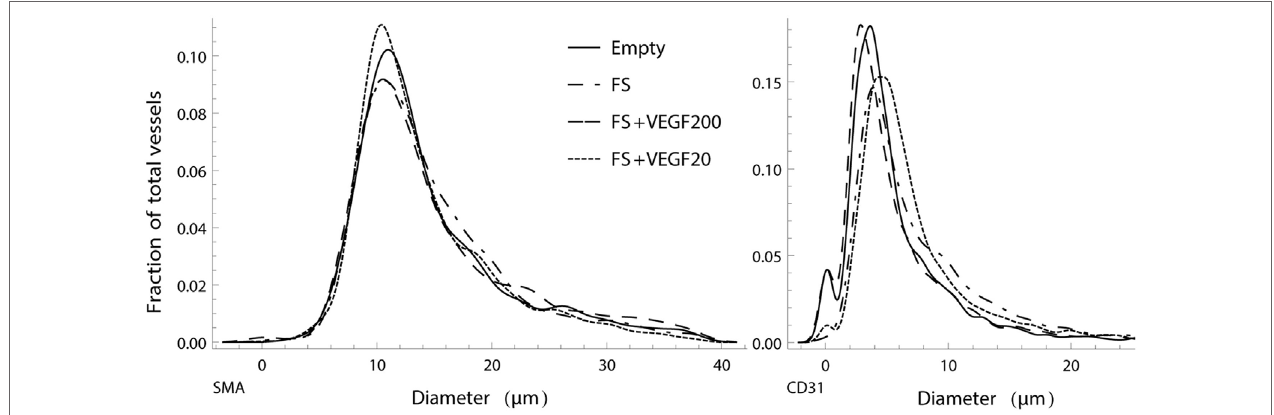
FIGURe 7 | Normalized, smoothed histogram of vessel diameters as a fraction of the total vessels count for smooth muscle actin (SMA) (left) and CD31 (right) staining. The distribution of vessel diameters in the vascular tree is similar between the study groups and suggests that there is no strong influence of the different treatments in regard to ratio of larger to smaller vessels.